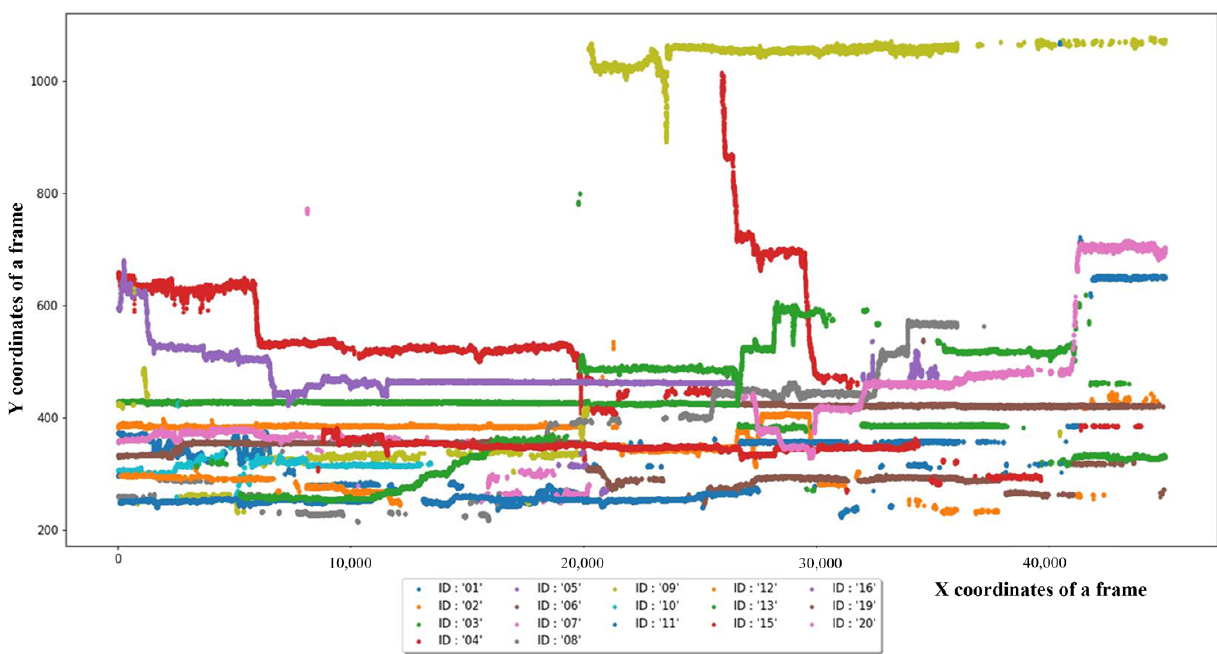
Figure 13. An analysis of tracking 20 head of cattle with the Detectron-2 with the light-weight tracking mechanism.